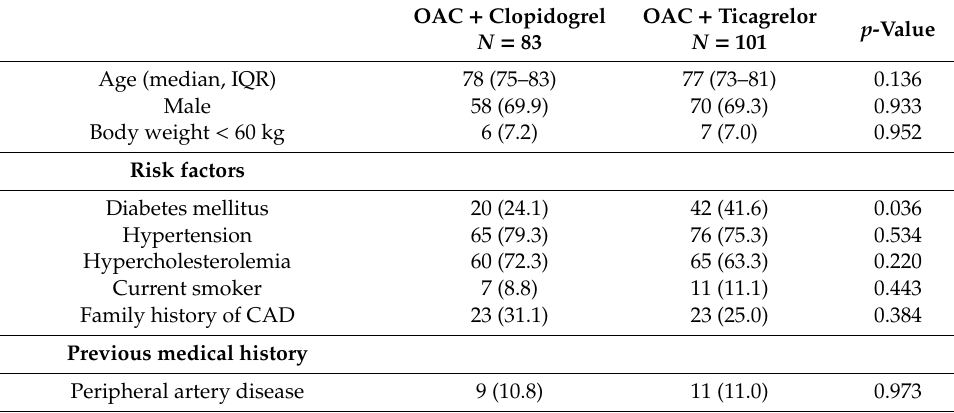
Table 1. Baseline